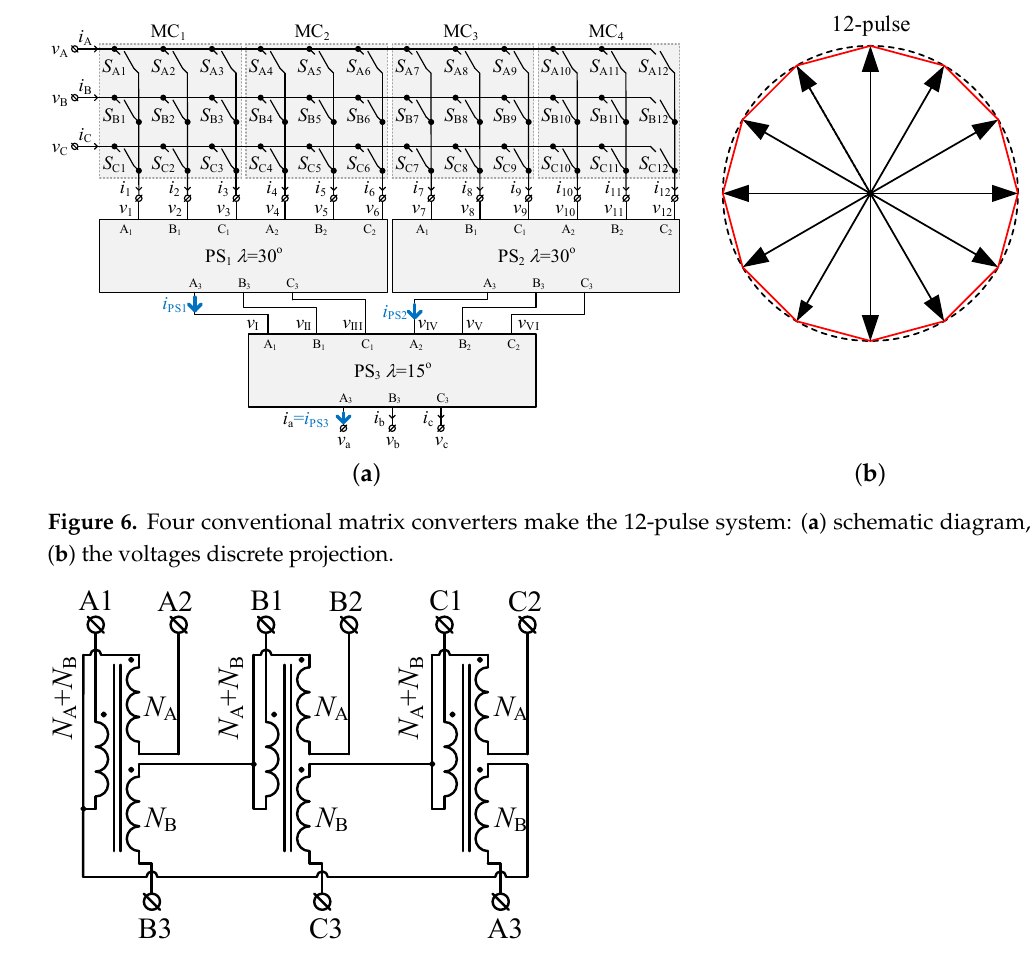
Figure 7. Phase Shifter